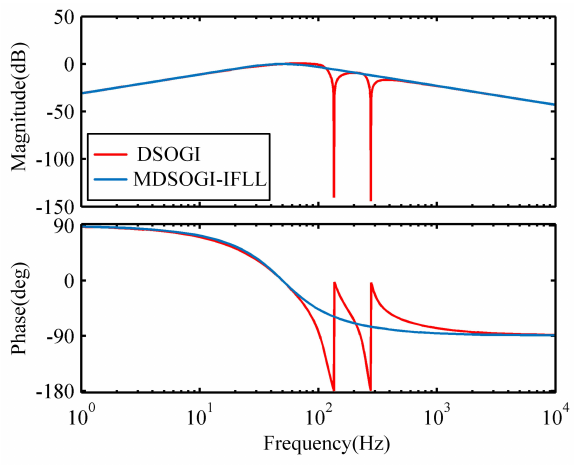
Figure 6. Bode diagram of the